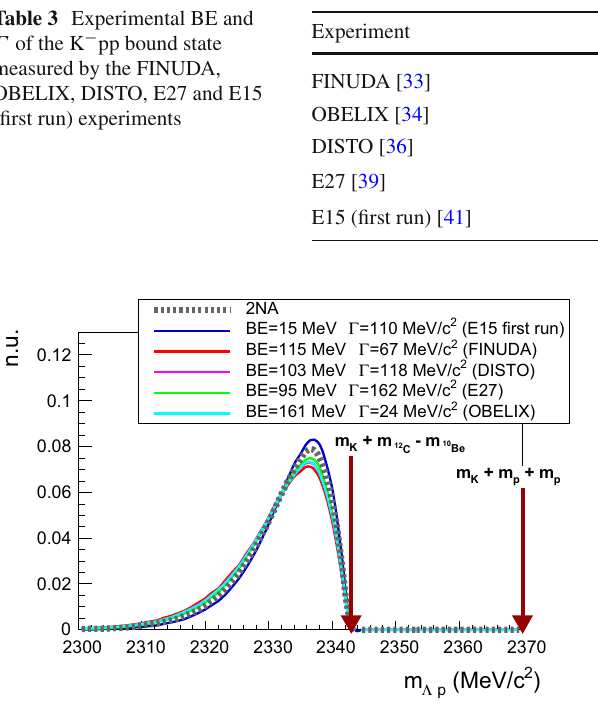
Fig. 6 Calculated invariant mass distributions of the (cid:2) p pairs from the K − pp bound state decay, produced in K − absorption on 12 C. The line shape of the 2NA (gray line) is shown for comparison together with the shapes obtained for the simulation of a bound state having binding energy and width selected according to the measurements of E15firstrun(blueline),FINUDA(redline),DISTO(magentaline),E27 (green line) and OBELIX (cyan line). The areas of the distributions are normalised to unity